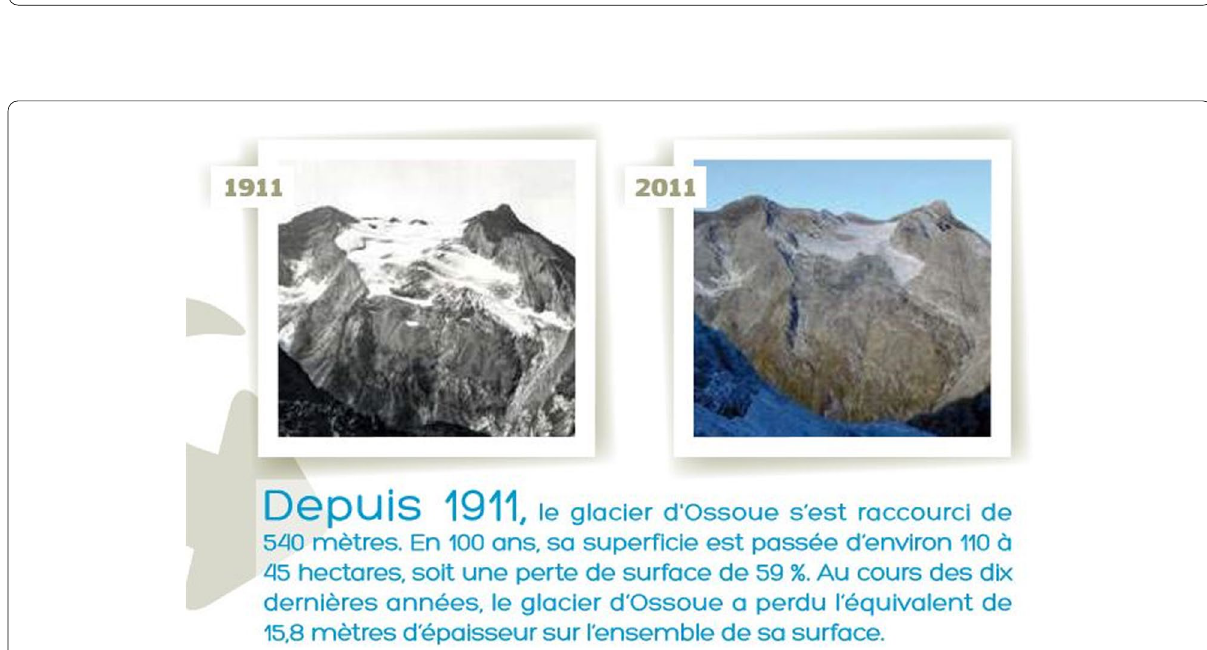
Fig. 3 Representative slide from a student presentation about Water Resource Management and climate change. https. ecolo gie. gouv. fr/ sites/ defau lt/ files/ ONERC_ Fiche sIndi cateur_ glaci er. pdf